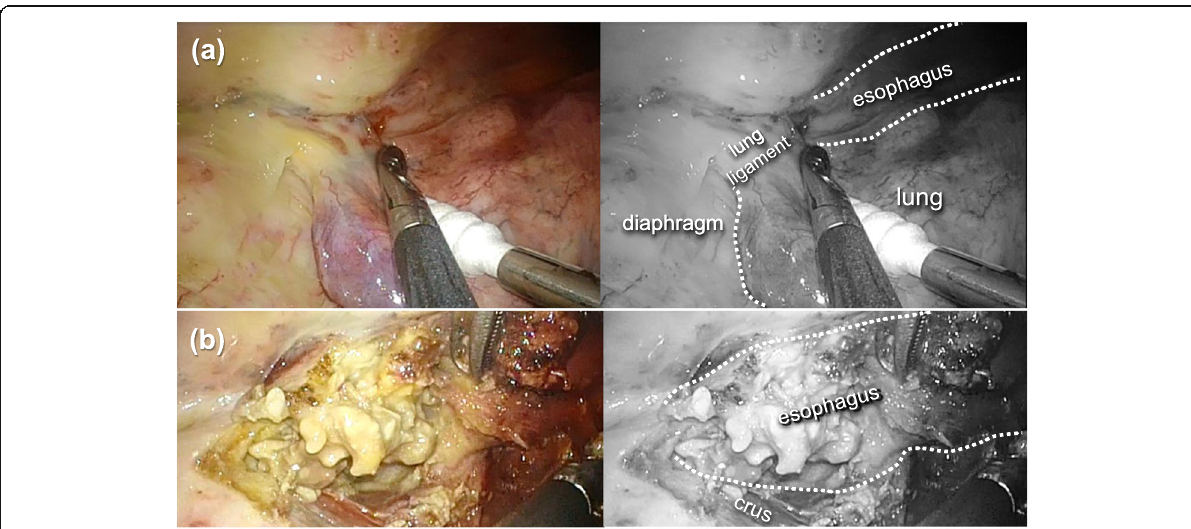
Fig. 4 Intraoperative findings. a The right lower mediastinal pleura and diaphragm around the irradiation field of proton beam therapy show ischemic changes with thickened wall in yellowish-white color. b The right lower esophageal wall above the diaphragm is necrosed in its full